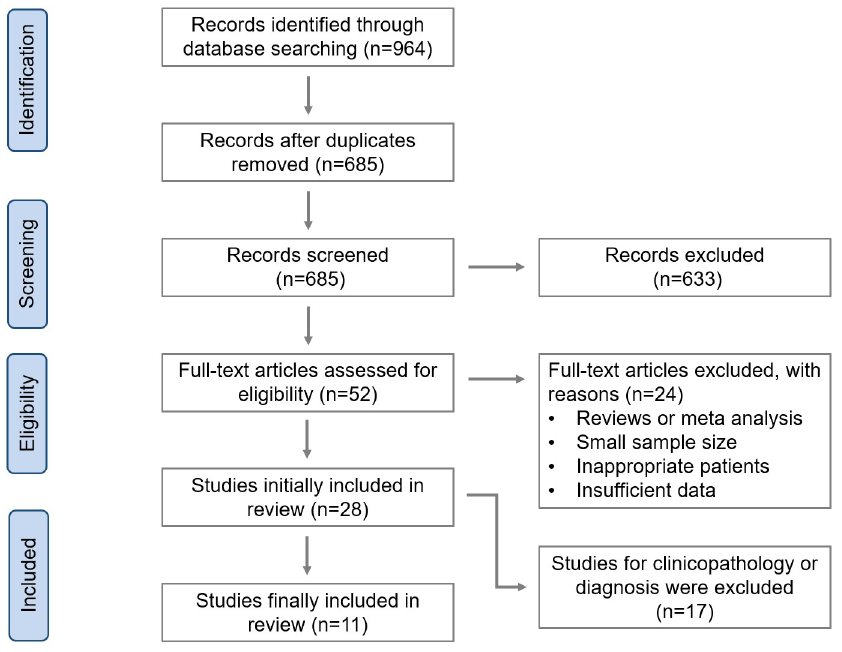
Fig 1. Flow chart for selecting eligible studies.